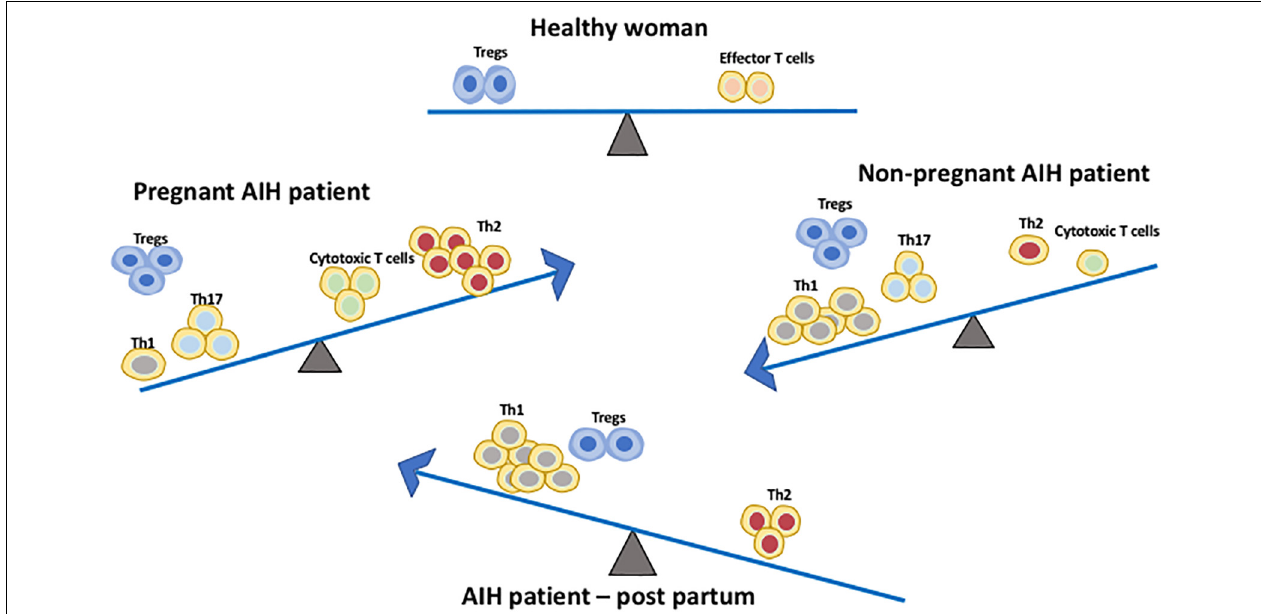
FIGURE 2 | Immune cell balance in the peripheral blood differs between healthy patients, non-pregnant AIH patients, AIH patients during pregnancy and AIH patients during early post-partum. The Th1/Th17:Th2 balance shifts from Th1/Th17 predominance in AIH patients without pregnancy to Th2 predominance during pregnancy. This immune balance is switched back to Th1 predominance post-partum. Treg frequency is increased in both non-pregnant and pregnant AIH patients. However, during post-partum their frequency is comparable to normal